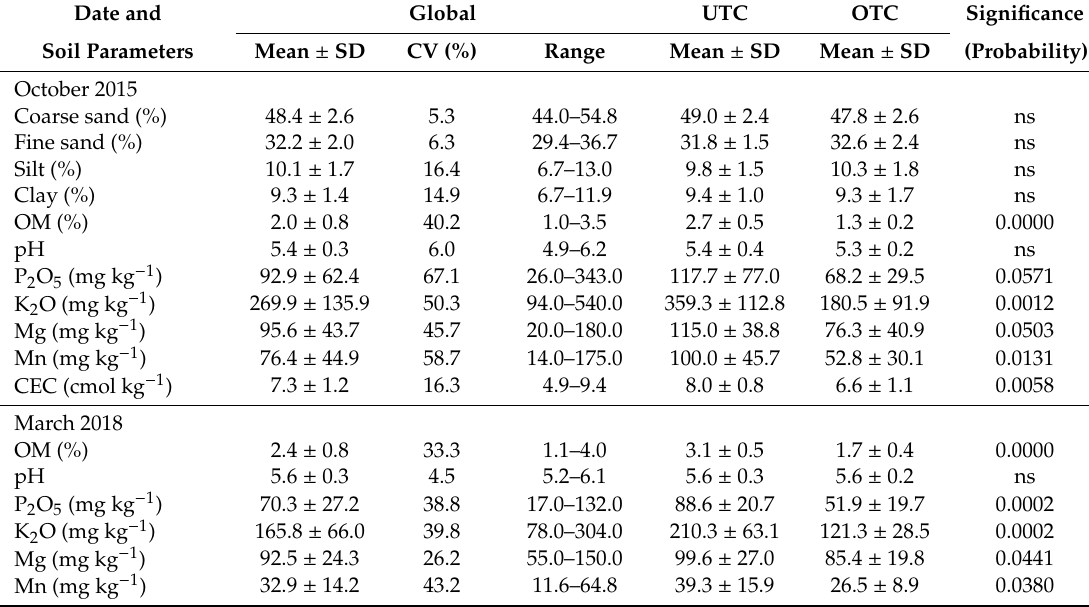
Table 1. Soil parameters in experimental field at 0–0.30 m depth in October 2015 and March 2018: Global (all sampling points), UTC (12 sampling points under tree canopy), and OTC (12 sampling points outside tree canopy).